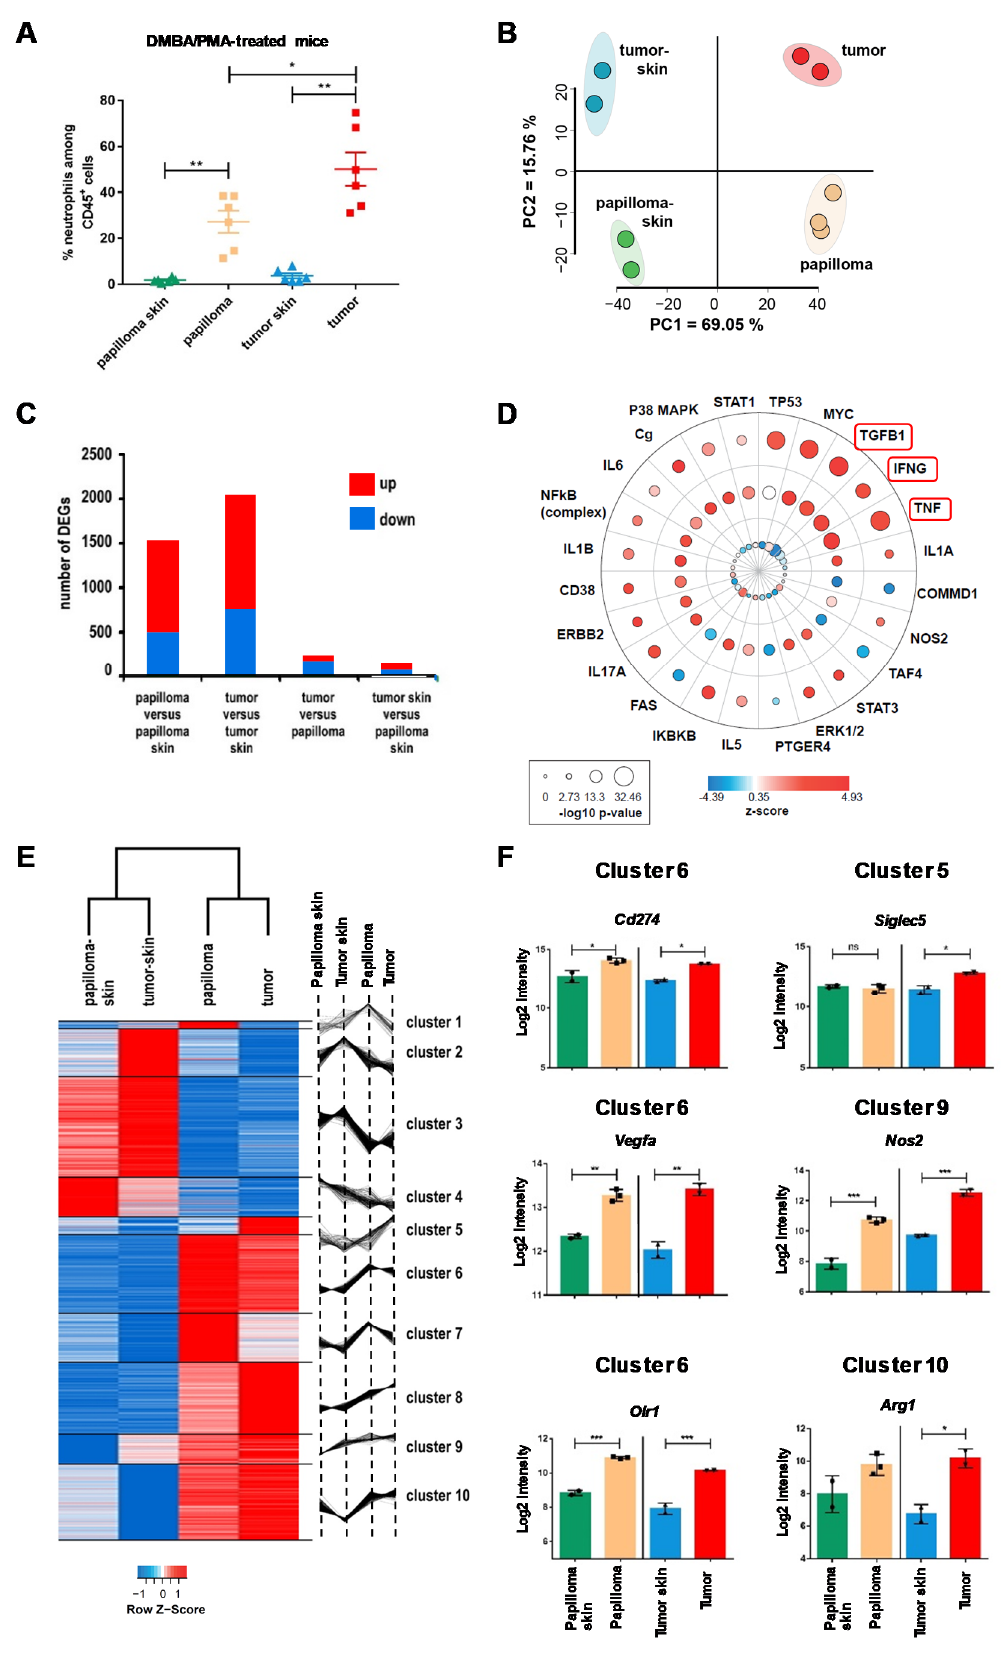
Figure 1. Distinct transcriptional signatures of neutrophils isolated from cSCC lesions and surrounding skin of DMBA/PMA-treated mice highlight their protumor functions. ( A ) Percentage of neutrophils among CD45+ cells in the skin surrounding papillomas (papilloma skin), within